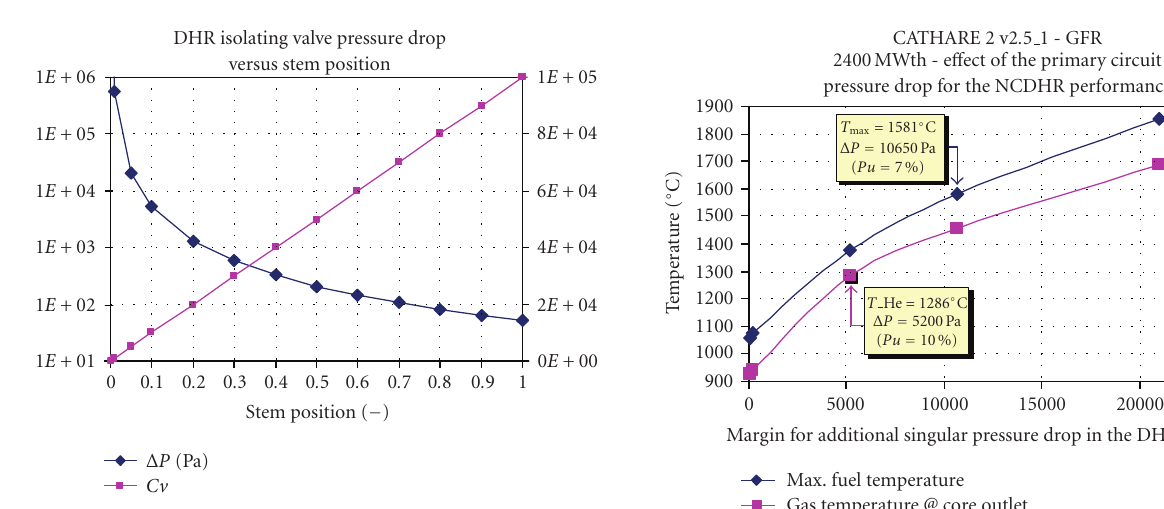
Figure 17: Flow coe ffi cient and related pressure drop versus stem position for DHR isolating valves.